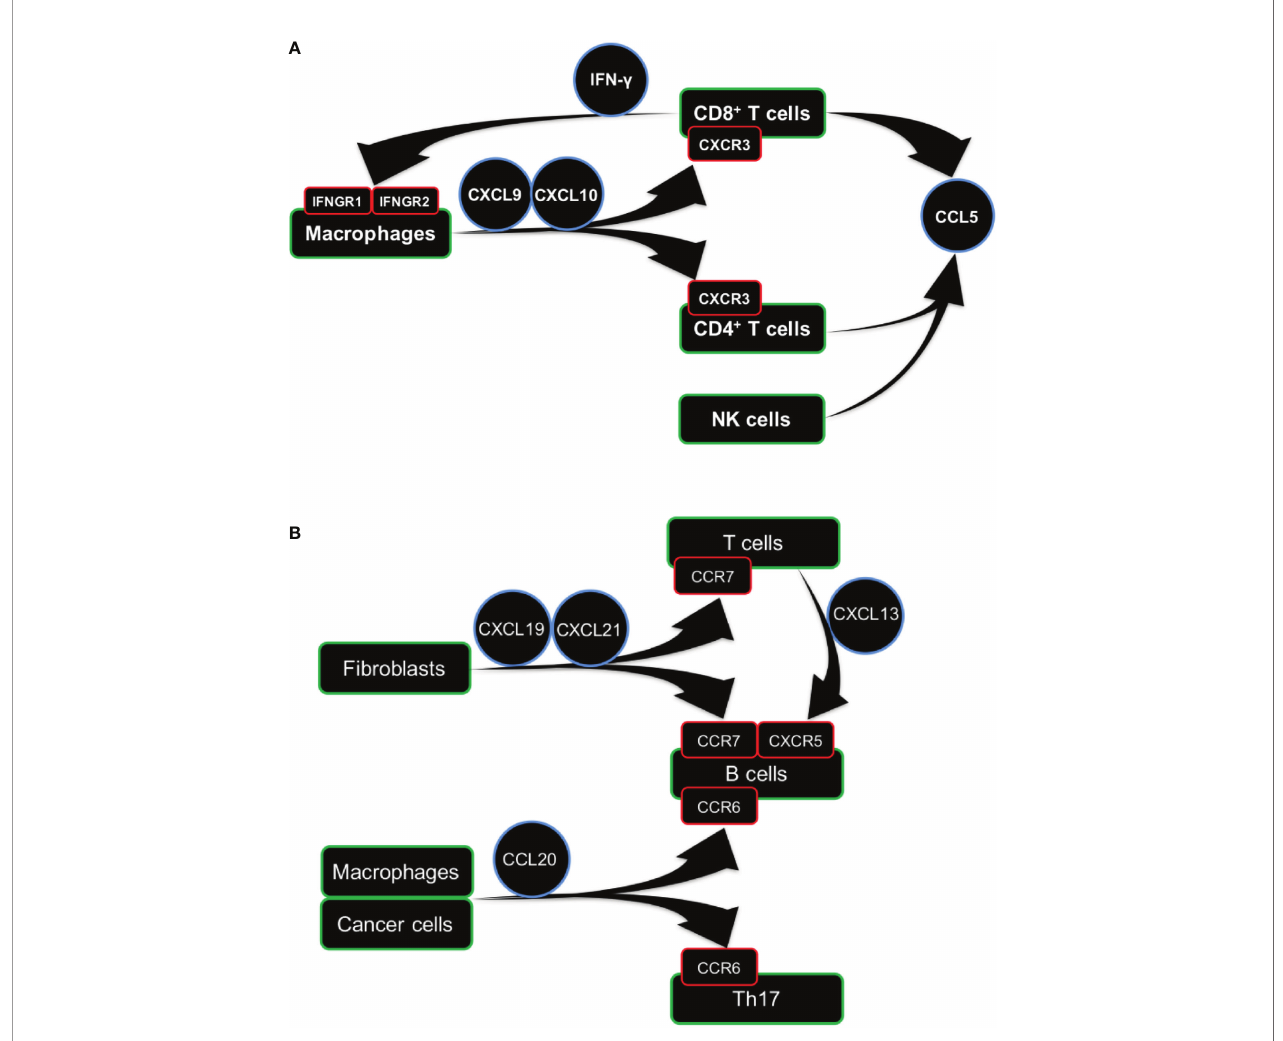
FIGURE 7 | Cellular communication network involving TIL-T and TIL-B cells. (A, B) Graphical representation of cellular communication network of TIL-T (A) and TIL-B (B) cells. Arrow represents the directions of ligand-receptor pairs expressed in the corresponding